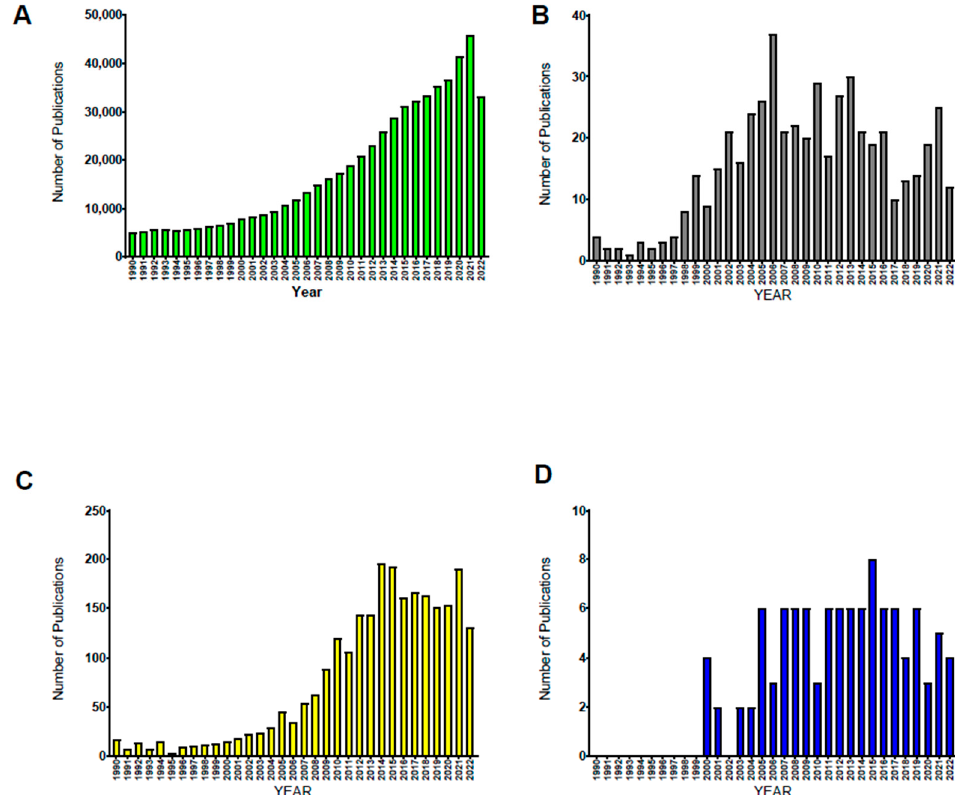
Figure 1. Publications in PUBMED from 1990 to 2022 for Four Methods of Noninvasive Pulsatile Shear Stress. Number of publications in PUBMED by year for the four methods described in this manuscript of noninvasive pulsatile shear stress: ( A ) Exercise, ( B ) Enhanced External Counterpulsa- tion, ( C ) Whole-Body Vibration, ( D ) Whole-Body Periodic Acceleration (also known as pGz).